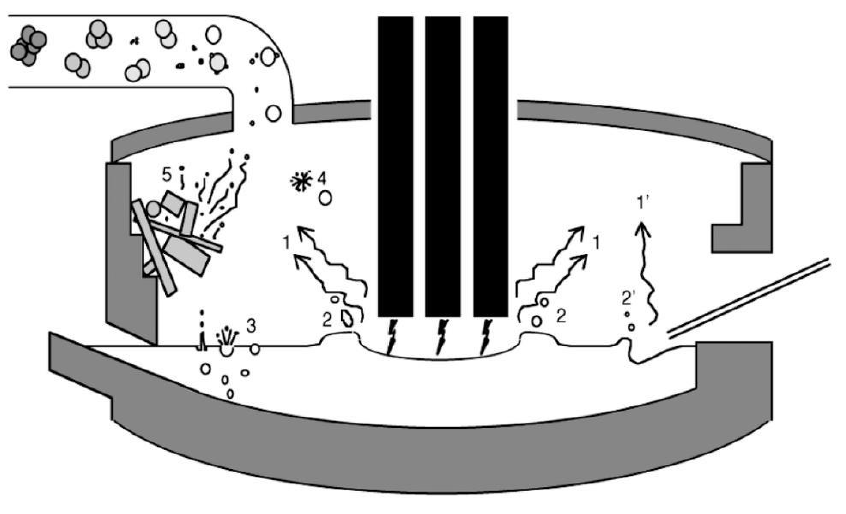
Figure 9. Mechanisms of dust generation in an electric arc furnace [21].